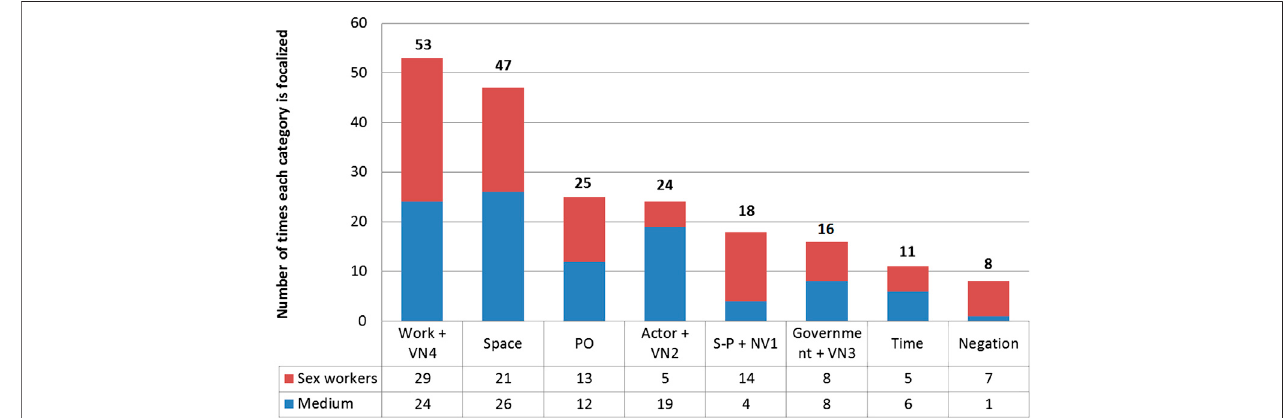
FIGURE 1 | Focus categories.